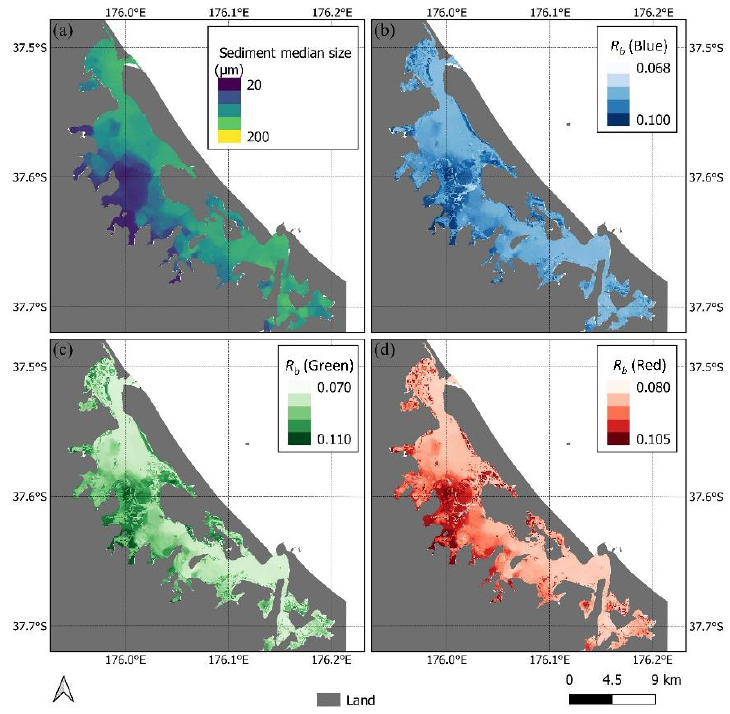
Figure 7. Maps of ( a ) median particle size derived from the sediment texture maps in Figure 1b–d using the cumulative curve and the estimated R b (from empirical relationships) in the ( b ) blue, ( c ) green and ( d ) red bands.